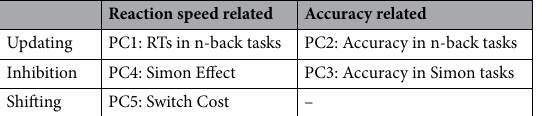
Table 3. Main compositions and classification of each component of the PCA.